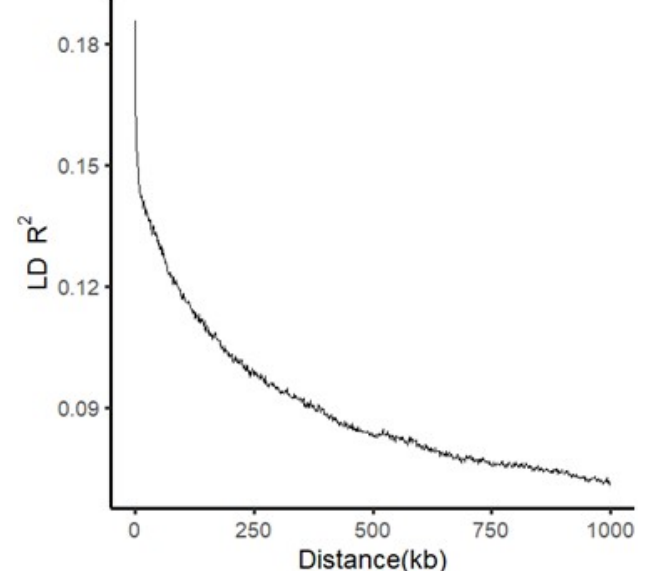
Figure 2. Pattern of LD decay in the whole panel of rice accessions used.